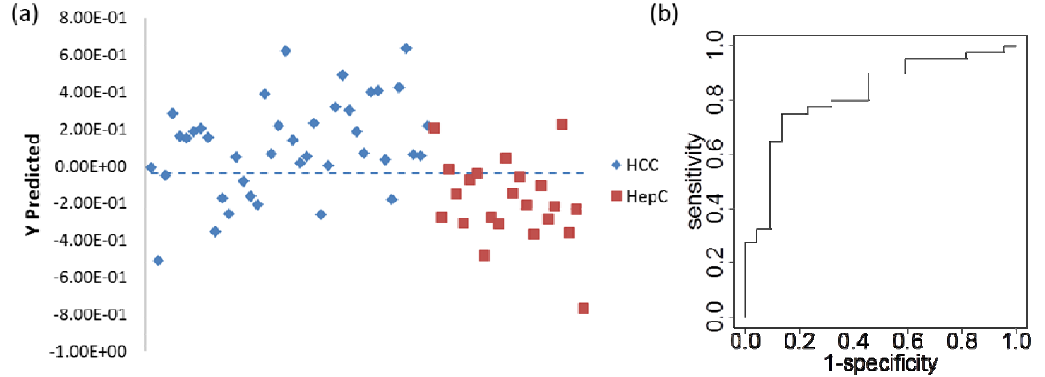
Figure 3. PLS-DA results for the model based on 3 potential metabolite biomarkers for differentiating HCC and HCV patient samples. (a) Cross-validation predicted class values.